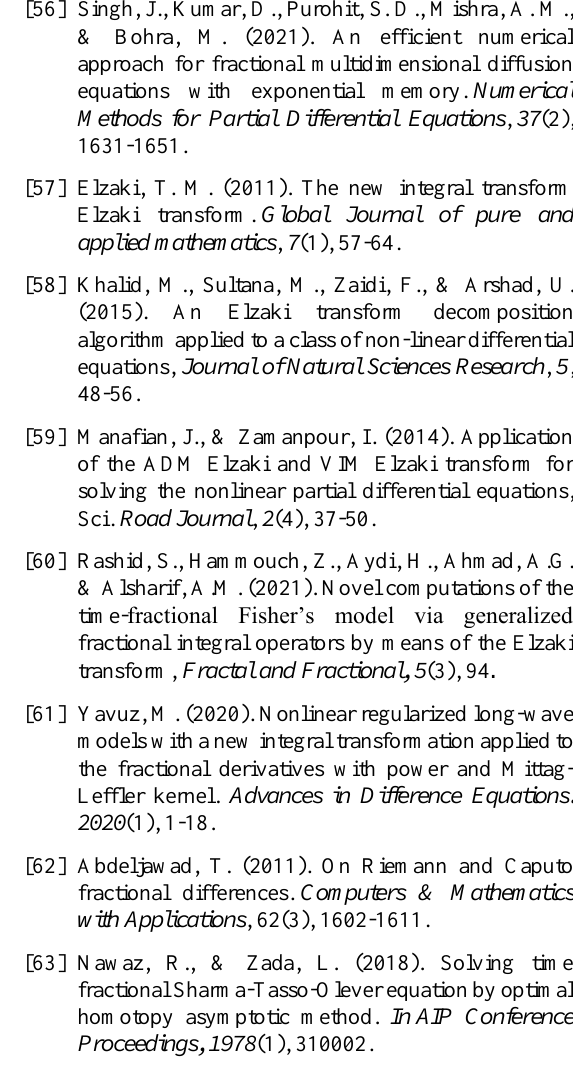
algorithm applied to a class of non-linear